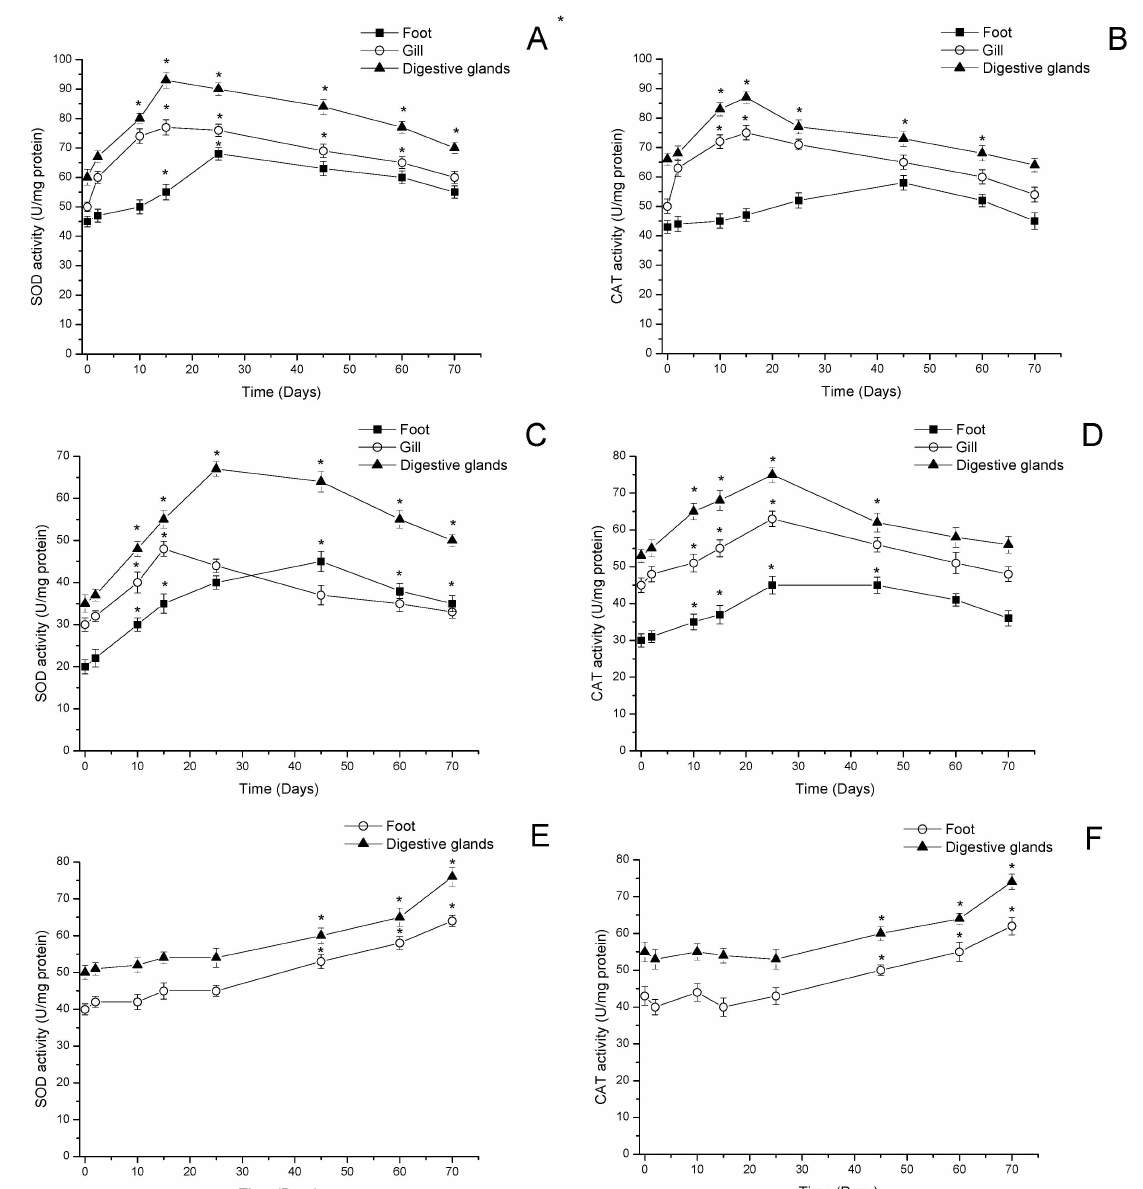
Figure 5. SOD and CAT activities in feet, gills, and digestive glands of ( A , B ) mussels ( Mytilus chilensis ), ( C , D ) clams ( Ameghinomya antiqua ), and ( E , F ) feet and digestive glands of locos ( Concholepas concholepas ) during a bloom of Alexandrium pacificum . Data are presented as the mean ± SEM. For significant differences compared to control (time point 0), values are indicated by an asterisk (*) in the data ( p < 0.05; Dunnett’s